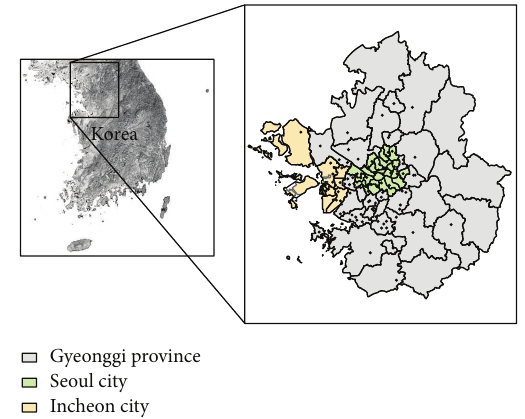
Figure 1: Locations of the study area and PM 10 monitoring stations (black dots) with administrative boundaries.